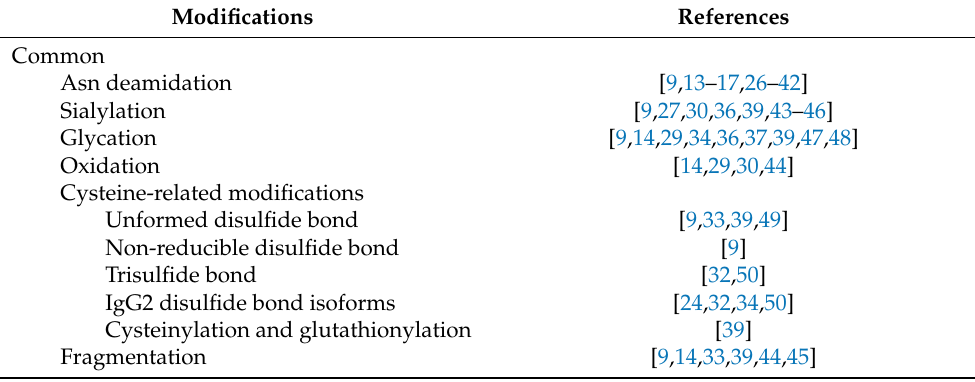
Table 1. Modifications in acidic